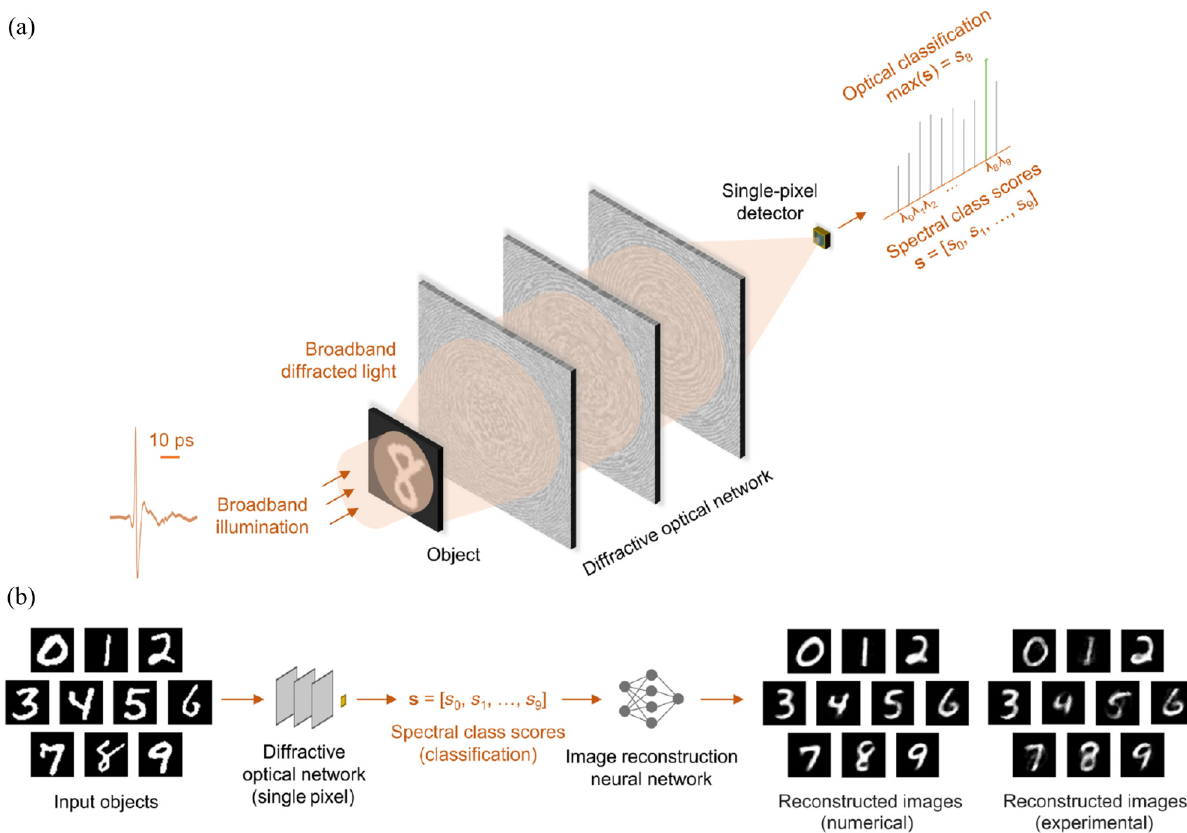
Figure 11: Schematics of spectral encoding of spatial information for object classification and image reconstruction. (a) Optical layout of the single-detectormachinevisionconceptforspectrallyencodedclassificationofobjects.Asanexample,ahandwrittendigiteightisilluminated with a broadband pulsed light, and the subsequent diffractive optical network transforms the object information into the power spectrum of thediffractedlightcollectedbyasingledetector.Theobjectclassisdeterminedbythemaximumofthespectralclassscores,s,definedovera setofdiscretewavelengths,eachrepresentingadataclass.(b)Schematicoftask-specificimagereconstructionusingthediffractivenetwork ’ s spectral class scores as input. A separately trained shallow artificial neural network recovers the images of handwritten digits from the spectral information encoded in s. Each reconstructed image is composed of >780 pixels, whereas the input vector, s, has 10 values. (a) and (b) are reprinted with permission from Ref. [120], copyright 2021